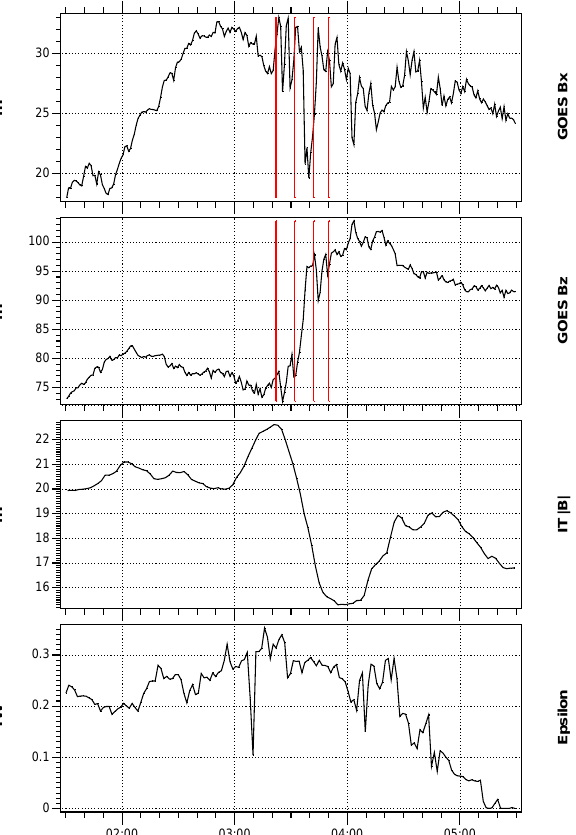
Fig. 3. B X and B Z from GOES-8 satellite (first and second panel) and total B from Interball Tail satellite (X GSM =− 24 R E , Y GSM = 2 R E , Z GSM = 7 R E , bottom panel). The vertical lines show the poleward motions experienced by the equatorward bound- ary of the proton emission band at 03:22, 03:32, 03:42 and 03:50 UT. The bottom panel shows the evolution of the Akasofu’s epsilon parameter as propagated to the